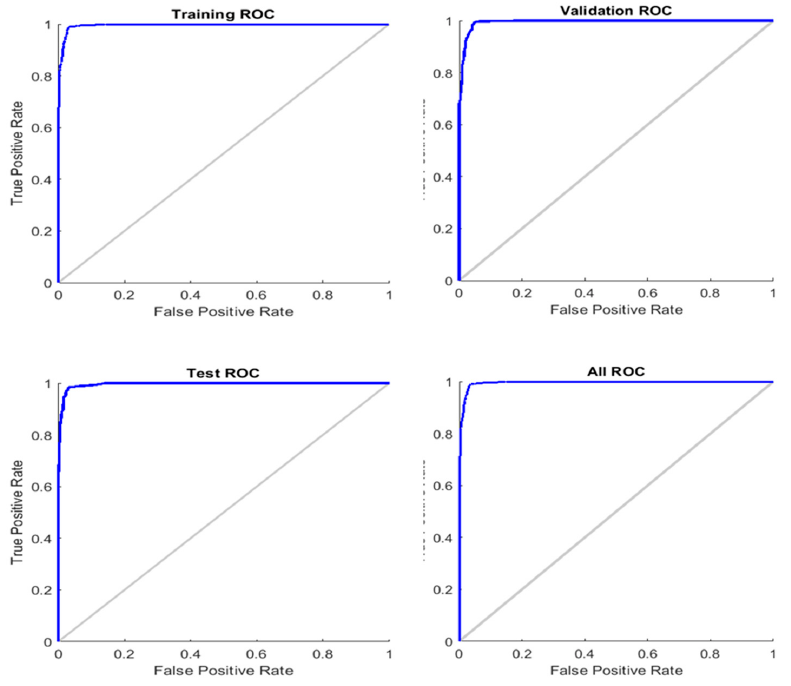
Figure 13. Confusion matrices for the tested scenario: drowsy driver (0) versus wakeful ones (1). Each of the confusion matrices report the performance of the proposed pipeline in discriminating drowsy / wakeful drivers for a selected subject from the collected dataset. For this subject-driver, the pipeline showed 97.5% of discrimination accuracy during the testing phase.